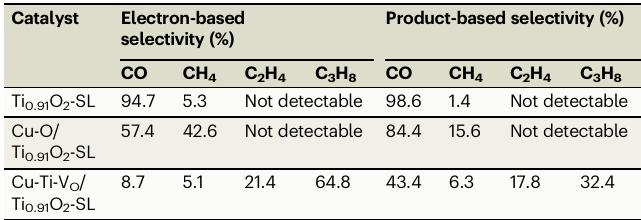
Table 1 | Selectivity of different products on Ti 0.91 O 2 -SL, Cu-O/ Ti